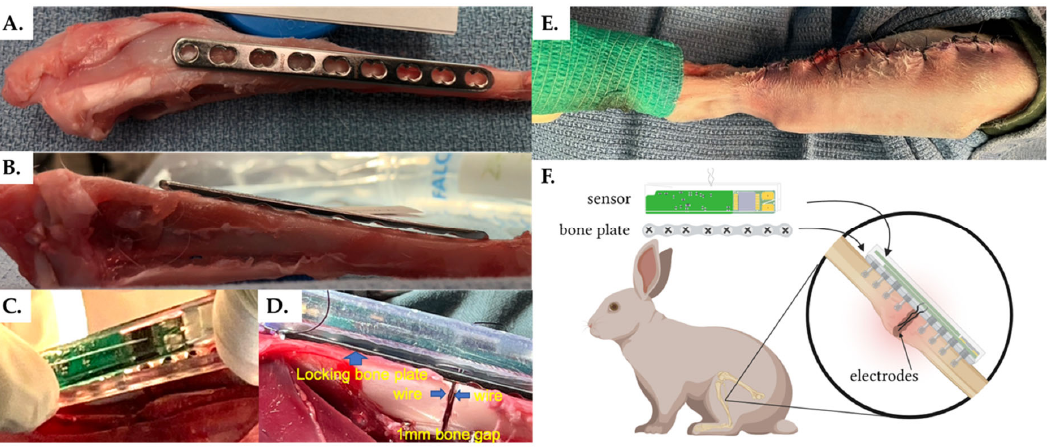
Figure 2. Experimental sensor implantation. ( A , B ) Surgical planning and sensor integration with ( C , D ) the bone fixation plate and ( E ) within the rabbit fracture model. ( F *) System overview. * Created with BioRender.com.